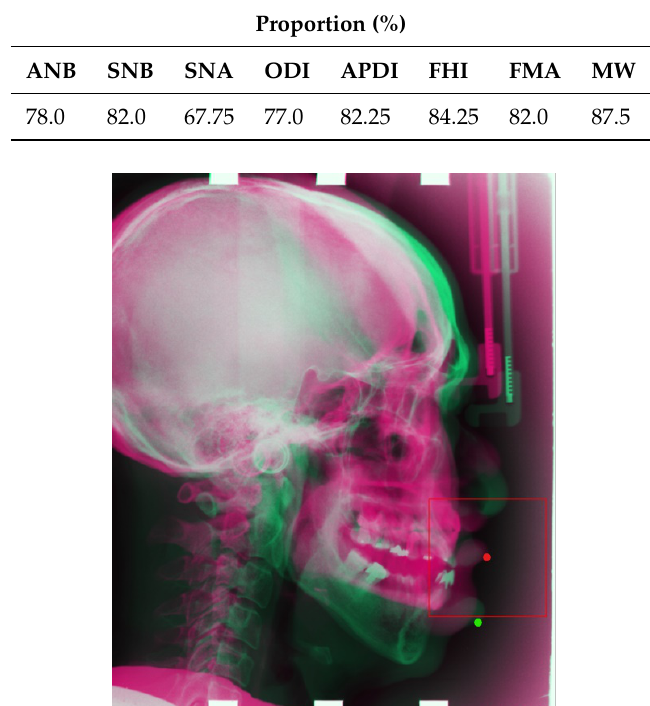
Table 8. The proportion that two doctors made the same classification label over 400 images (training and test images).